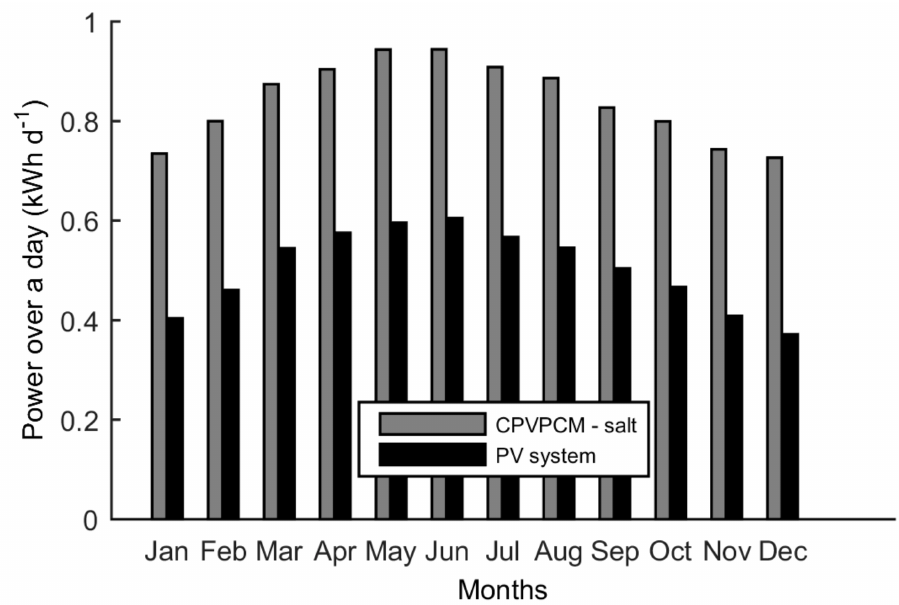
Figure 17. Comparison of power generated over a day for a CPVPCM system with salt and PV